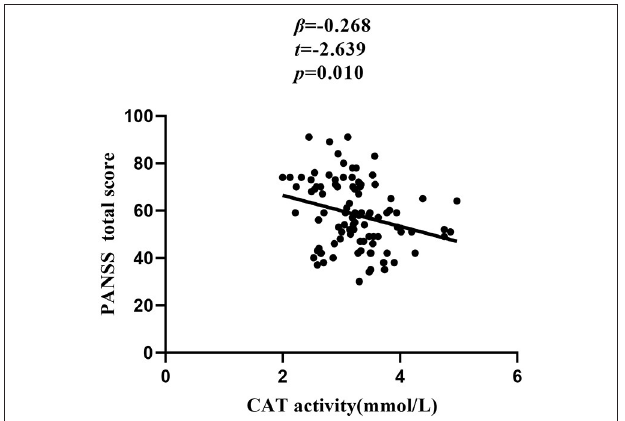
FIGURE 4 | Correlation between plasma GSH-Px activity and Visuospatial/Constructional score in chronic schizophrenia patients.